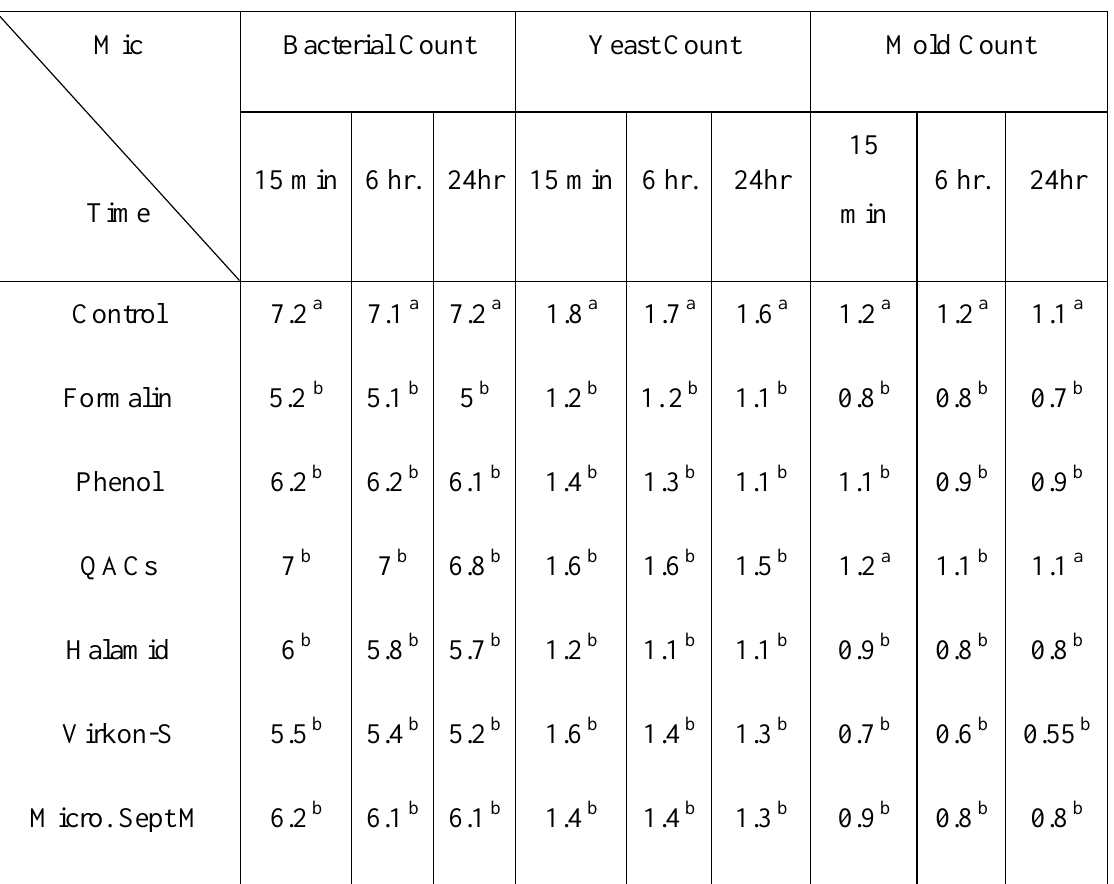
Table 2: The effect of low application level and contact time on total aerobic bacteria, yeast, and molds: Bacterial Count Mic